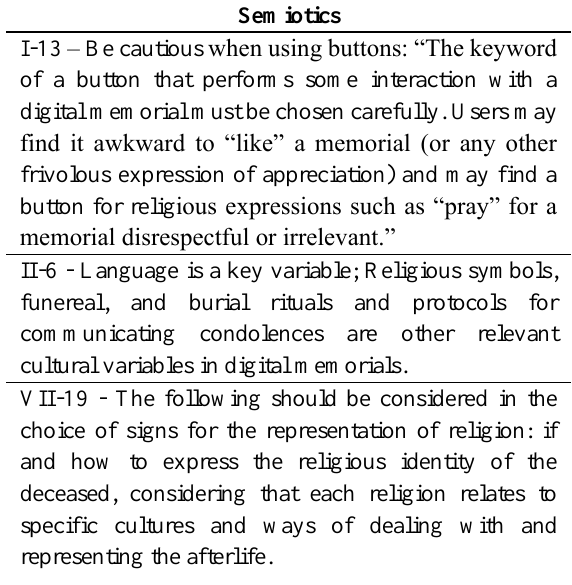
Table 4. Semiotics. (To be continued) Semiotics